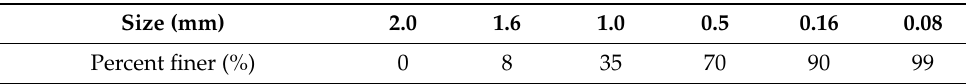
Table 4. Mixture proportion of cement Table 2. Physical properties of carbon nanotubes (CNTs).